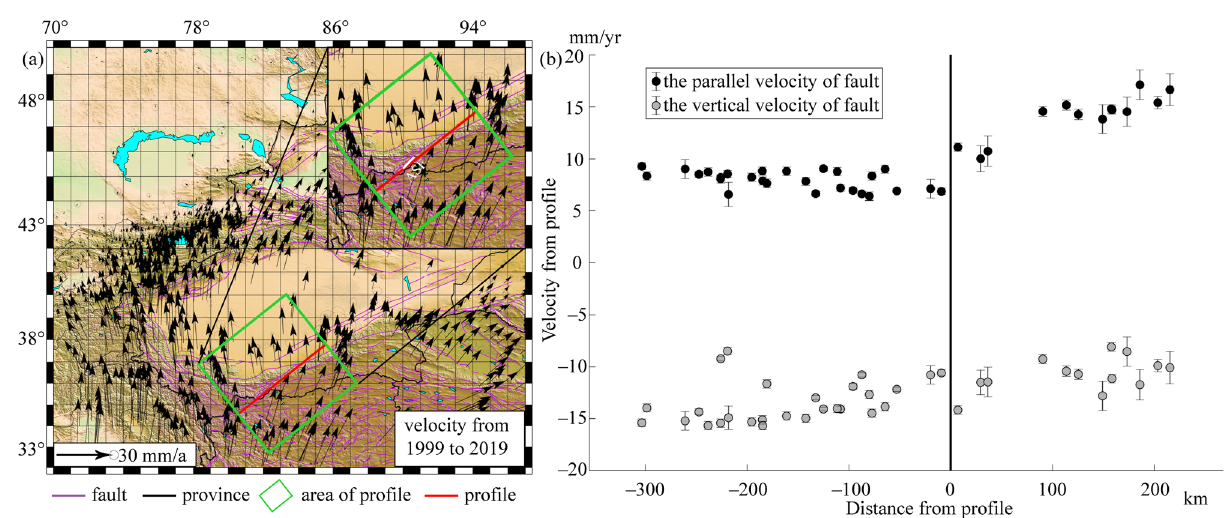
Figure 7. GPS velocity fields before the occurrences of earthquakes on the Ashikule fault zone ( a ) and the N 50°E velocity profile ( b ). Velocity components eastward and northward are designated positive; the white line in the upper panel on the left is the ASF (Ashikule fault). The Fig. 7a was generated by using the Generic Mapping Tools (GMT) 4 (https:// www. gener ic- mappi ng- tools. org/ downl oad/, accessed on 27 September